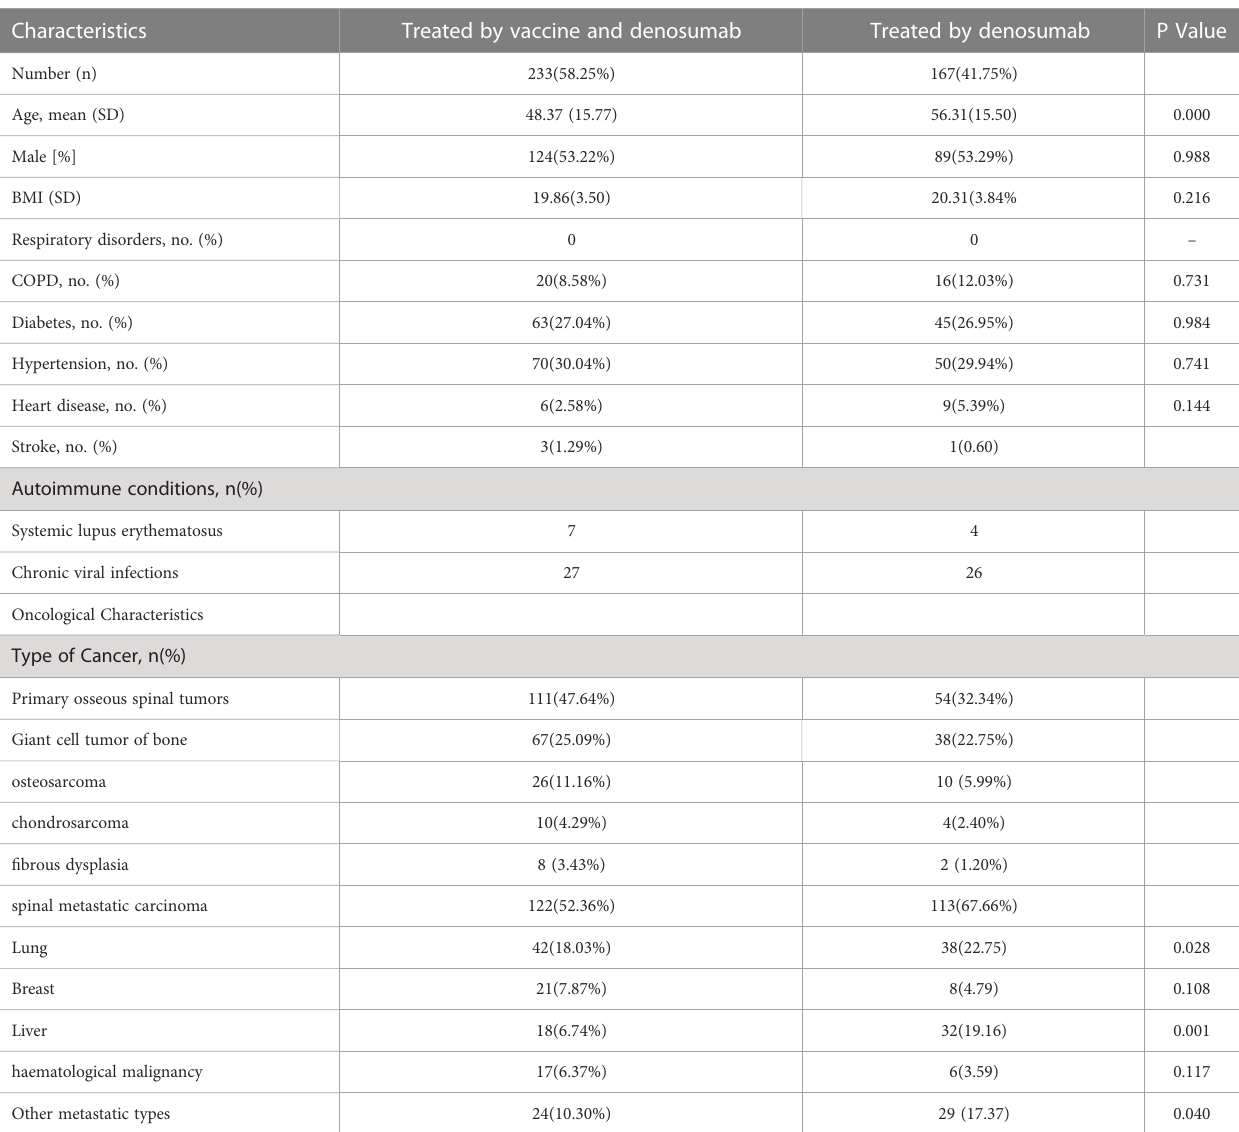
TABLE 1 Oncological